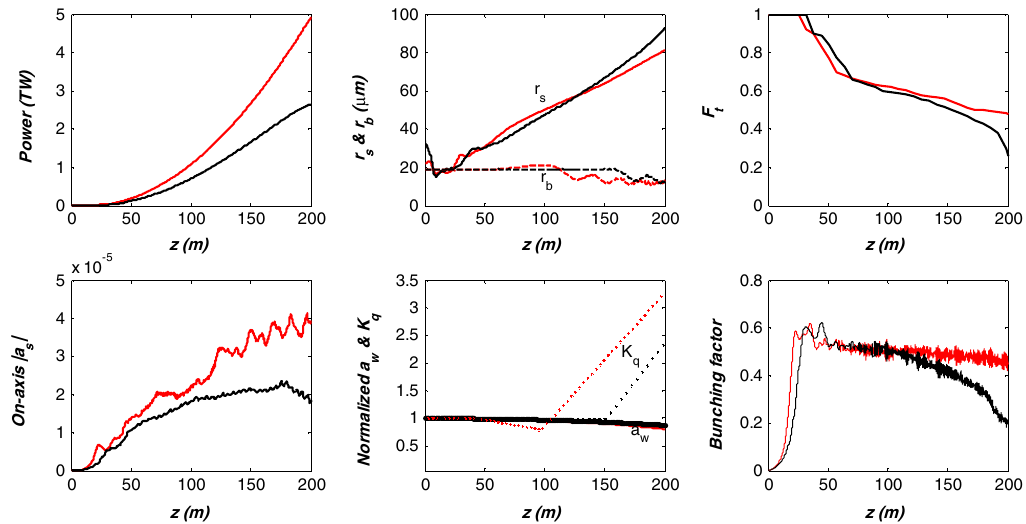
j , r , F , and bunching factor in a s s t variations are b